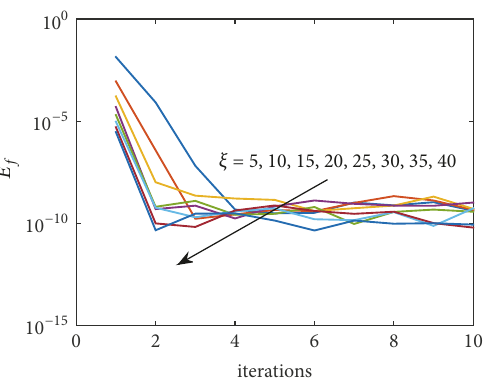
Figure 6: Convergence error graph of 𝑓(𝜁,𝜉) at different values of 𝜁 , 𝑁 𝜂 = 60 , 𝑁 𝜁 = 5 , 𝑛 = 𝑤 = 1/2 , 𝑃𝑟 = 0.7 , 𝑆𝑐 = 0.6 , and 𝑧 = 40